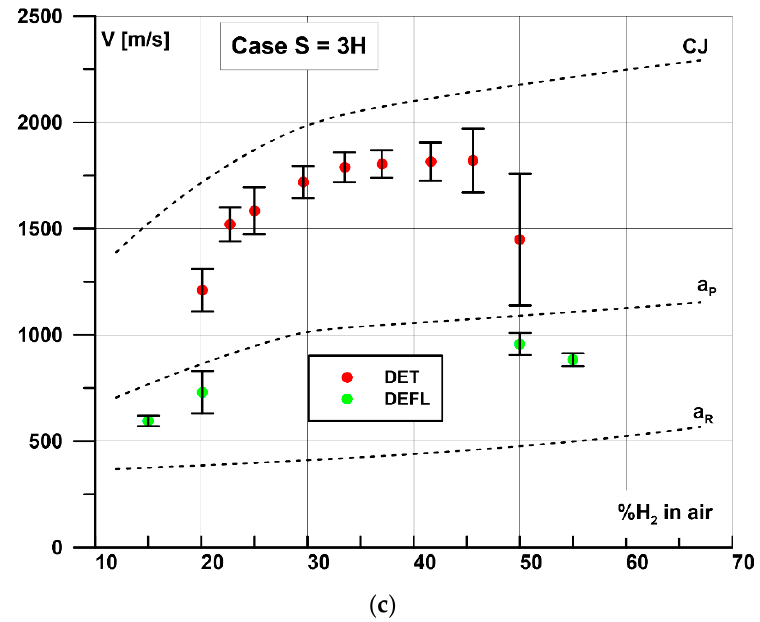
Figure 4. Mean velocities recorder for deflagration experiments (green dots) and experiments with DDT (red dots) for three obstacles configurations: ( a ) S = H, ( b ) S = 2H, ( c ) S = 3H [31]. CJ—Chapman Jouguet detonation velocity, a p —speed of sound in products, a r —speed of sound in reactants. Whiskers correspond to the minimum and maximum velocities recorded within the mixture investigated. DET—case with successful transition to detonation, DEFL—case with deflagration only.